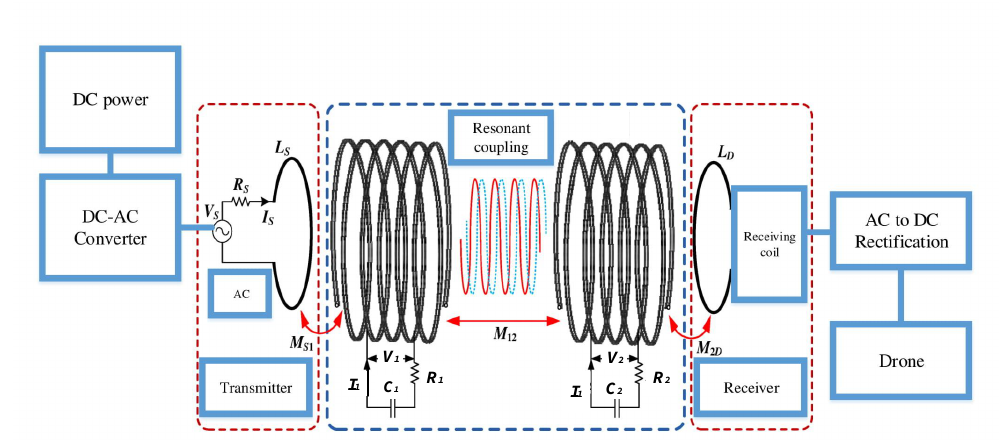
Figure 9. Typical resonant coupling